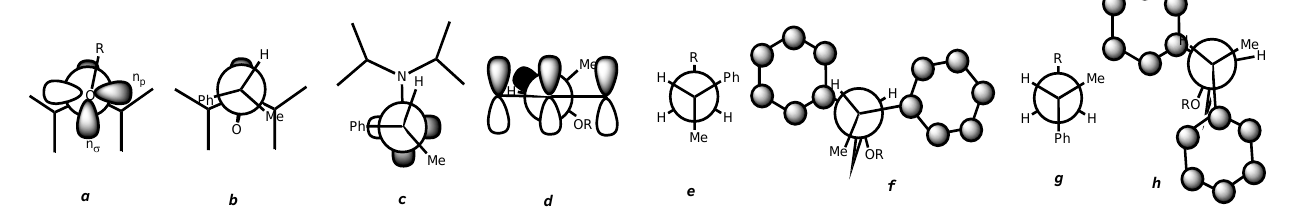
Table 1. Geometrical parameters (bond length l , interatomic distance d , valence angle  and torsion angle  ), interaction energy, and formation enthalpy  H the B3LYP/6-31G(d) level of theory.